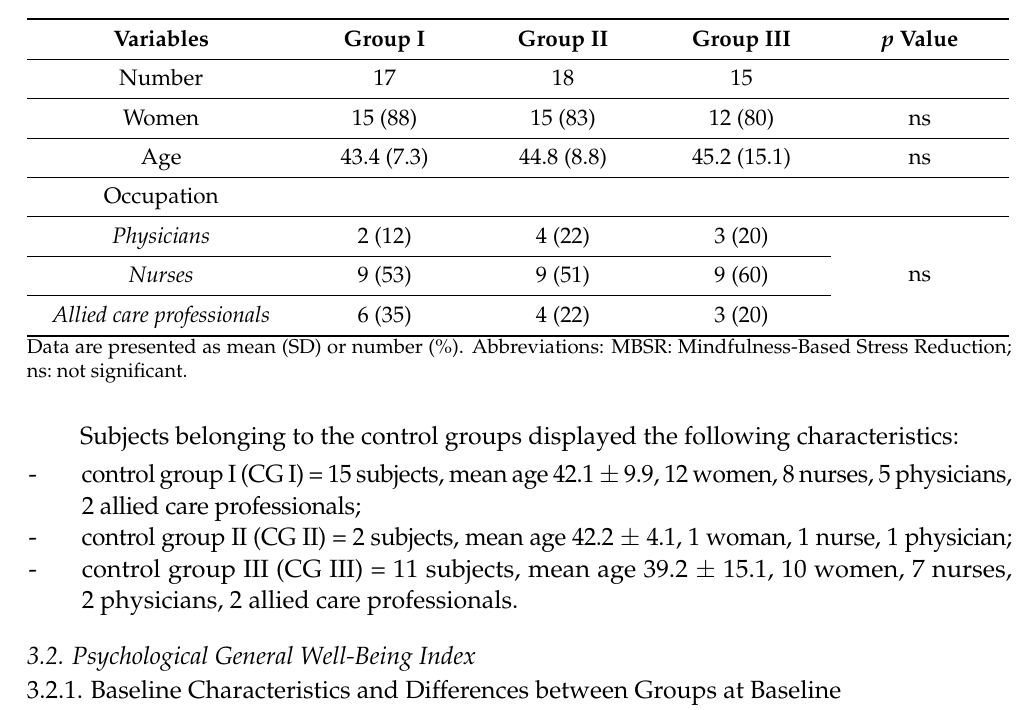
Table 1. Characteristics of MBSR course